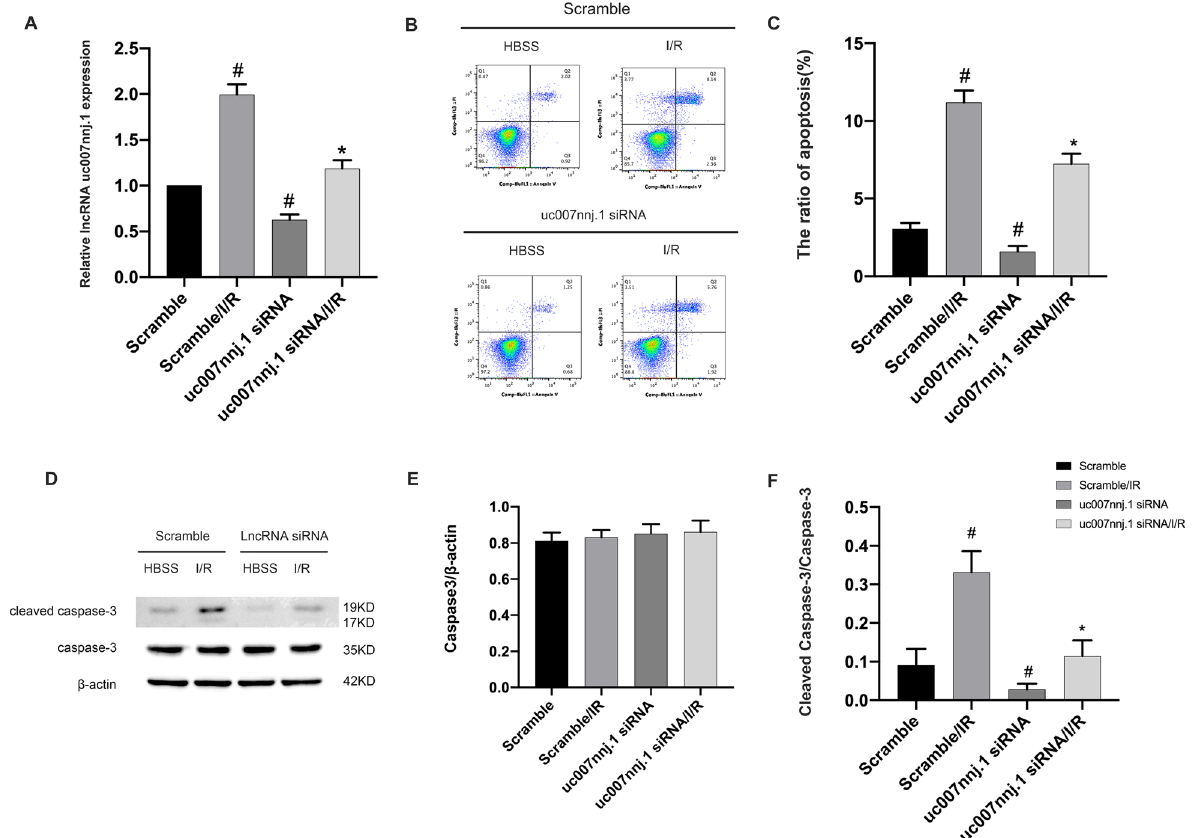
Fig. 2 lncRNA uc007nnj.1 deletion alleviated ischemia-induced neuronal apoptosis. RGCs were transfected with 50 nM scramble siRNA or lncRNA uc007nnj.1 siRNA for 24 h and then treated with or without I/R injury. A RT-qPCR analysis of the expression of lncRNA uc007nnj.1. B , C Measurement of total apoptosis by flow cytometry in RGCs. The Q1 area represents necrotic cells, the Q2 area represents late apoptotic cells, the Q3 area represents early apoptotic cells, and the Q4 area represents normal cells. D Representative image showing a Western blot of caspase-3 and cleaved caspases-3. E , F Quantitative analysis of immunoreactive bands of caspase-3 ( E ) and cleaved caspase-3 ( F ). Data are expressed as mean # p < 0.05, scramble with I/R group or lncRNA uc007nnj.1 siRNA group versus scramble group; * p < 0.05, lncRNA uc007nnj.1 siRNA with I/R